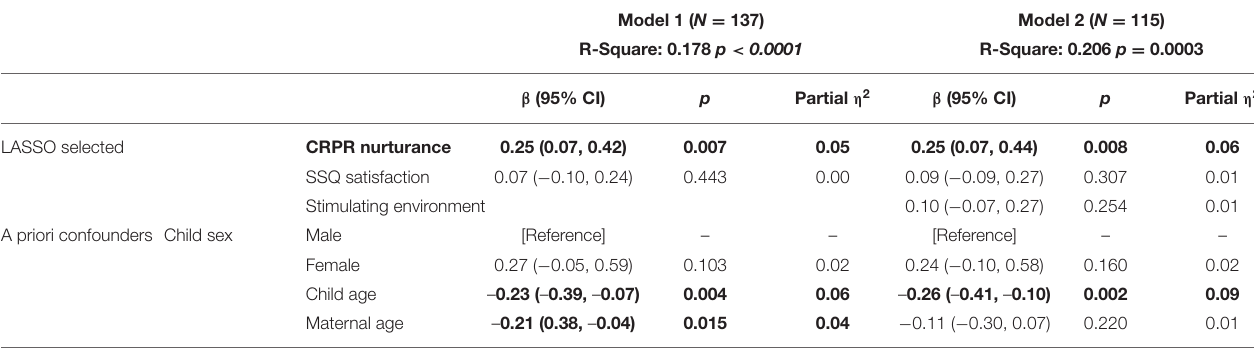
TABLE 5 | Results from the adjusted model of LASSO-selected predictors for adaptive behavior with standardized